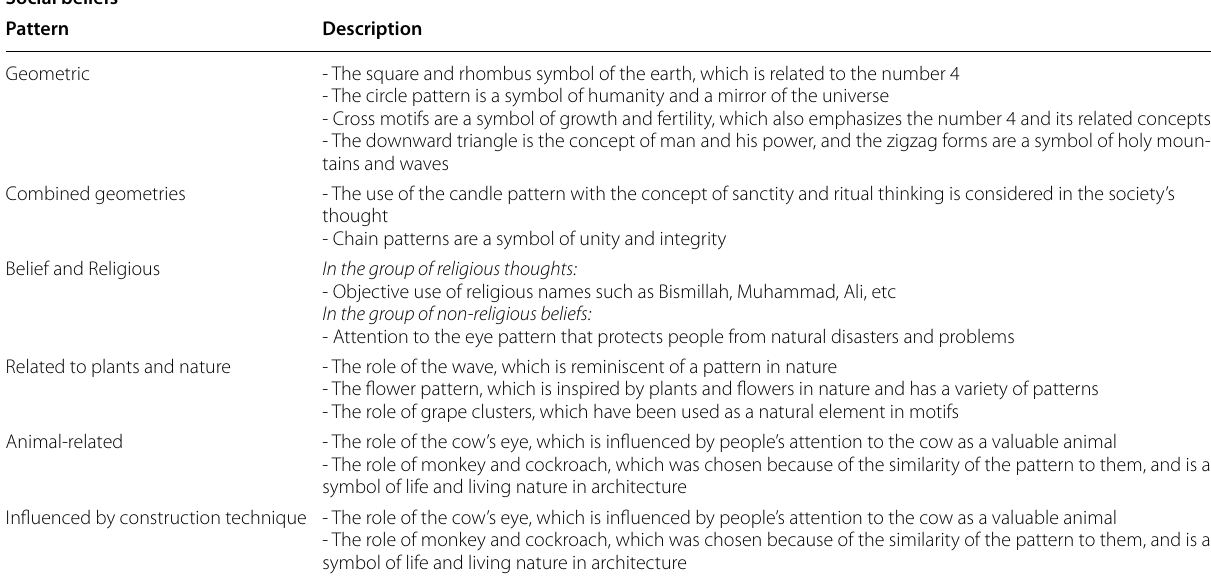
Table 8 The influence of social beliefs and beliefs in different decorative groups